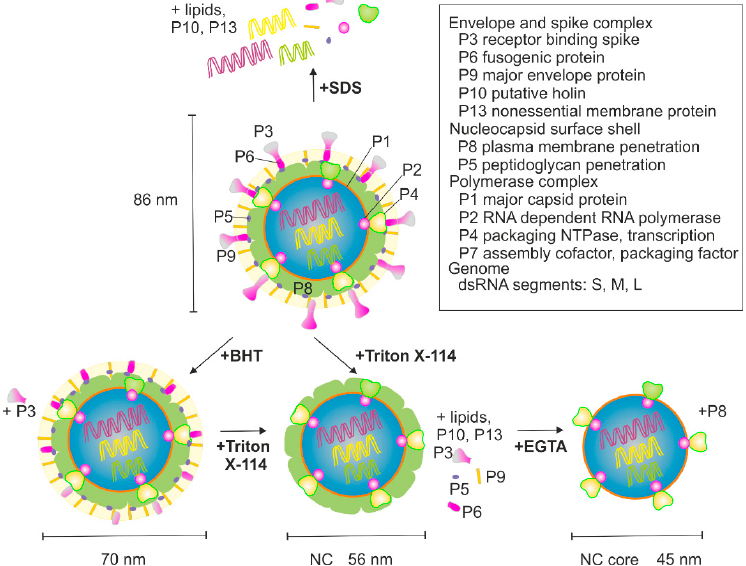
Figure 1. Schematic presentation of φ 6 virion and the flow chart for the used treatments. An intact virion is shown at the top. The nucleocapsid (NC) core is made of four proteins P1, P2, P4, and P7 that encapsidate the three dsRNA segments L, M, and S. NC consists of the NC core that is covered with P8. The viral envelope embeds membrane proteins P6, P9, P10, P13, and P3 spike protein via P6. Treatments performed in this study with the expected outcome are also shown. See Materials and Methods for details.